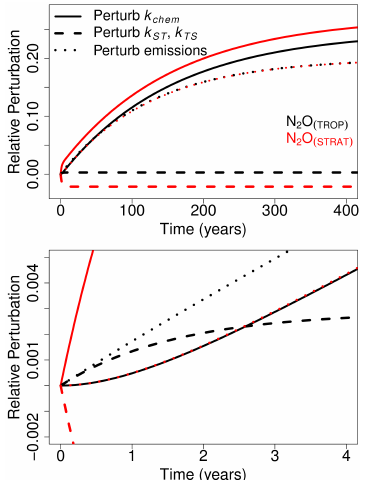
Figure 7. Results from a two-box model illustrating the sensitiv- ity of the tropospheric N 2 O burden (and hence source inversions) to the N 2 O stratospheric loss rate and to the rate of stratosphere– troposphere exchange. Shown are the relative perturbations to the tropospheric (black lines) and stratospheric (red lines) N 2 O bur- dens resulting from a 20% change in the N 2 O stratospheric loss frequency (“Perturb k chem ”, solid lines), a 20% change in the rate of stratosphere–troposphere exchange (“Perturb k ST , k TS ”, dashed lines), and a 20% change in emissions (“Perturb emissions”, dotted lines). The top panel shows results over a 400-year timescale, while the bottom panel shows the initial 4